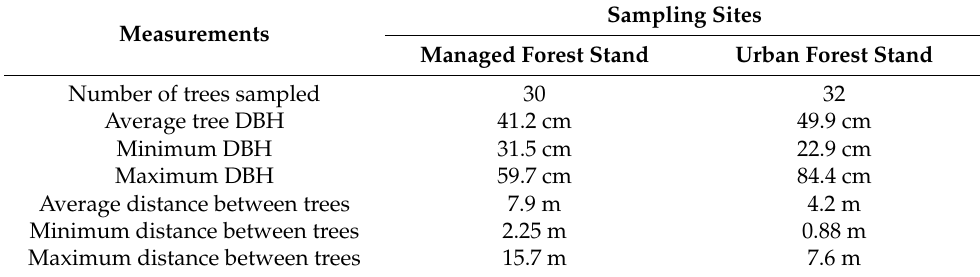
Table 3. Field plot